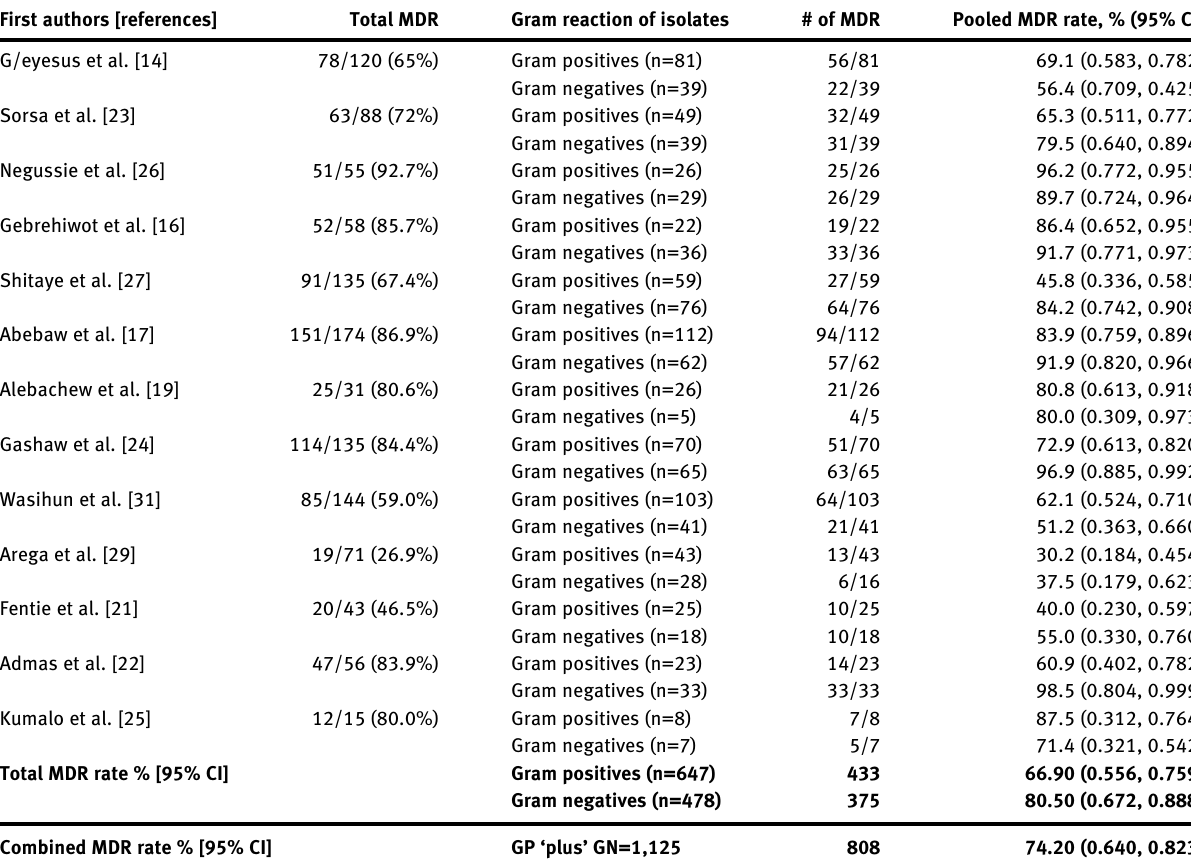
Table  : Pooled multi-drug resistance (MDR) rates of bacteria causing septicemia in